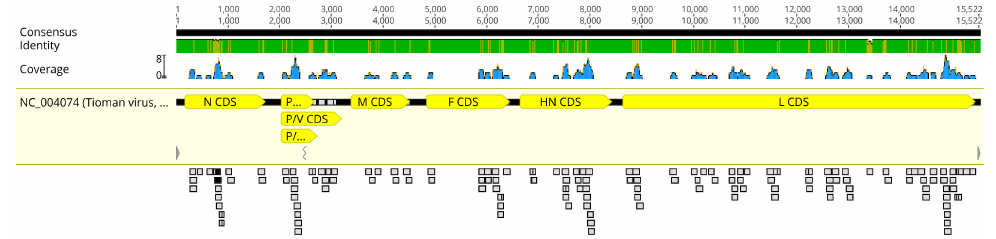
Figure 2. Coverage of next generation sequencing reads from a Pteropus vampyrus assembled to a reference genome of Tioman virus (Accession number: NC_004074). Coverage ranged from 0–8 nucleotides across the genome, represented in blue above the annotated reference